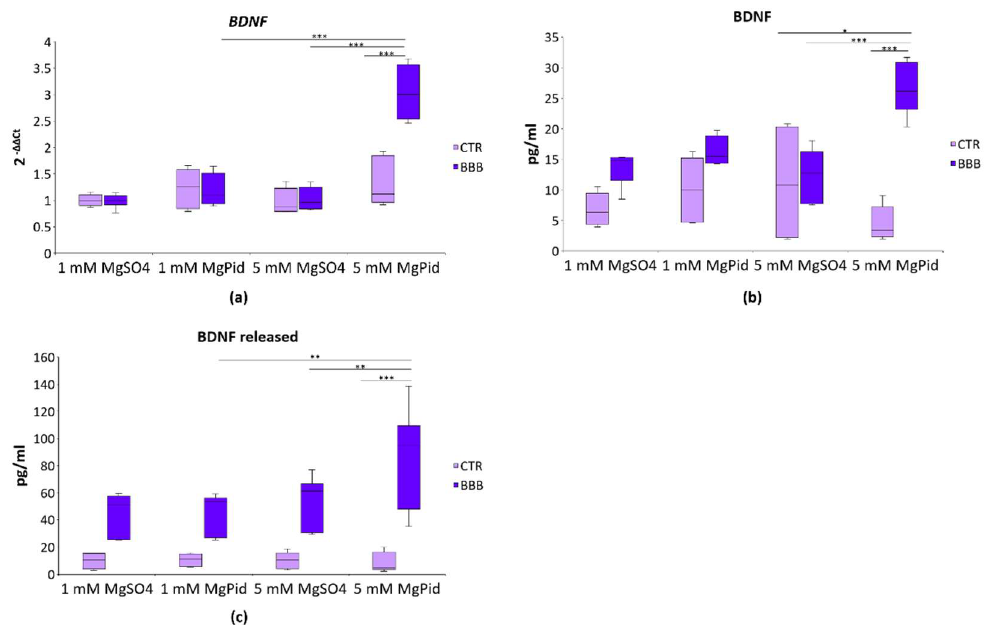
Figure 5. BDNF modulation in brain organoids and in the culture media in the presence or absence of the BBB. Human brain organoids were cultured in the presence or absence of the BBB, treated with 1 or 5 mM MgSO 4 or MgPid for 4 days. Each experimental sample was obtained by pooling three organoids. ( a ) BDNF expression was measured using real-time PCR on RNA extracted from the brain organoids. The mRNA expression values were normalized to GAPDH mRNA levels. Box plot for real-time PCR data is shown; ( b ) Box plot shows the BDNF levels in the human brain or- ganoids, as measured by ELISA; ( c ) Box plot shows the amount of released BDNF in the culture media, as measured by ELISA. Each box represents the interquartile range (25th to 75th percentiles), the horizontal line inside is the median value, and the whiskers represent the range. All the experi- ments were performed at least three times in triplicate. Two-way ANOVA was performed. * p ≤ 0.05, ** p ≤ 0.01, *** p ≤ 0.001. 3. Discussion Beyond its critical role in metabolism, Mg is crucial in the nervous system because of its neuroprotective action against excitotoxicity by acting as an antagonist of NMDA-R. Mg also potentiates GABA signaling, controls nerve conduction and neuromuscular transmission, prevents oxidative stress, and downregulates inflammatory mediators [6]. Clinical studies indicate that patients with mood disorders show deranged Mg homeosta- sis [26]. Accordingly, administering Mg has a beneficial effect on anxiety [9]. A recent clinical trial concluded that Mg supplementation provides significant clinical benefits in stressed healthy adults [27]. Mg seems to be beneficial in depression [28] and in relieving headache [29]. Therefore, there is an increasing interest in Mg as a molecule capable of harmonizing neuronal circuits. To understand how Mg affects the nervous system, animal models have been utilized and have provided valuable insights into the mechanisms re- sponsible for neurological and behavioral disorders under Mg-deficient conditions [30,31]. However, translatability is often limited because of the major differences between the brains of humans and animals [32]. Three-dimensional brain organoids emerged as a revolutionary tool to study the response to various compounds. Therefore, to obtain novel insights into the mechanisms underlying the Mg effect in the brain, we utilized brain or- ganoids exposed to two different Mg salts: the inorganic MgSO 4 and the organic MgPid, which seem to possess different bioavailability [4,33]. Moreover, because of the crucial role of the BBB in controlling the exchange to and from the brain [34], we compared the effects of the two different concentrations of Mg salts on brain organoids maintained, or